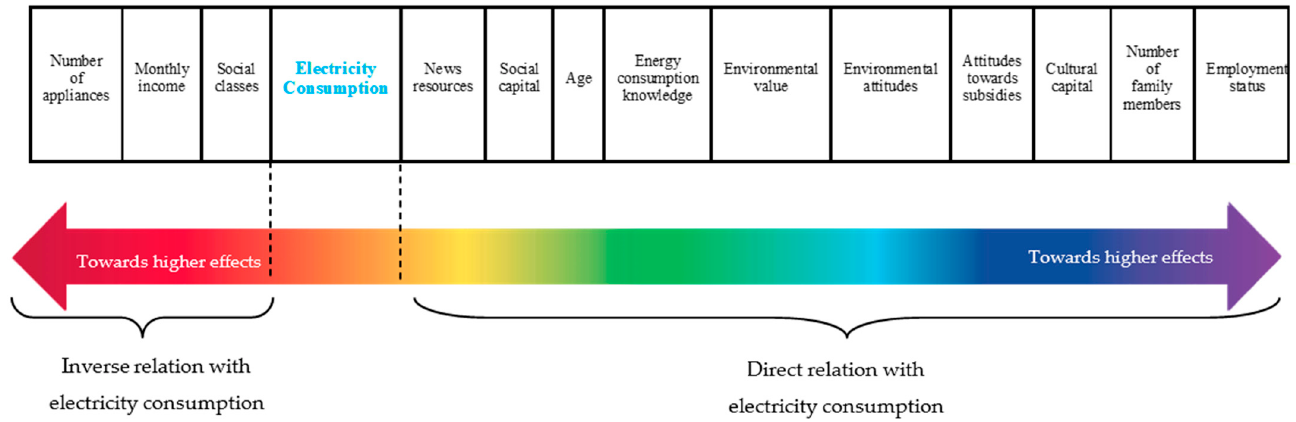
Figure 3. Relation between electricity consumption and different factors.